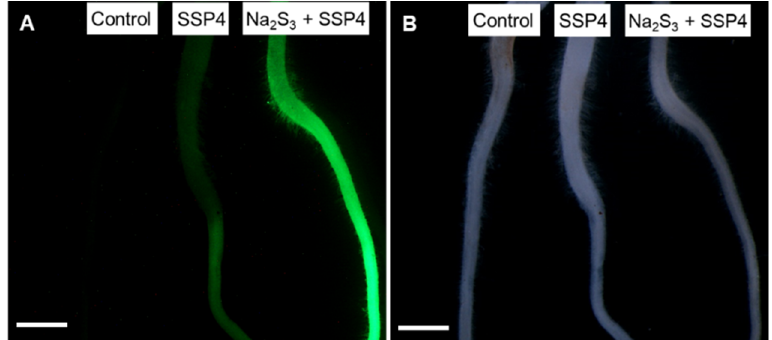
Figure 1. Detection of reactive sulfur species (RSS) in the roots of Lotus japonicus MG-20. Seedlings were incubated for 1 h with SSP4 for detection of RSS or incubated with the sulfane sulfur donor Na 2 S 3 for 1 h prior to incubation with SSP4. Fluorescence ( A ) and bright field ( B ) images. Control seedlings were incubated with phosphate-buffered saline. Scale bars, 5 mm.